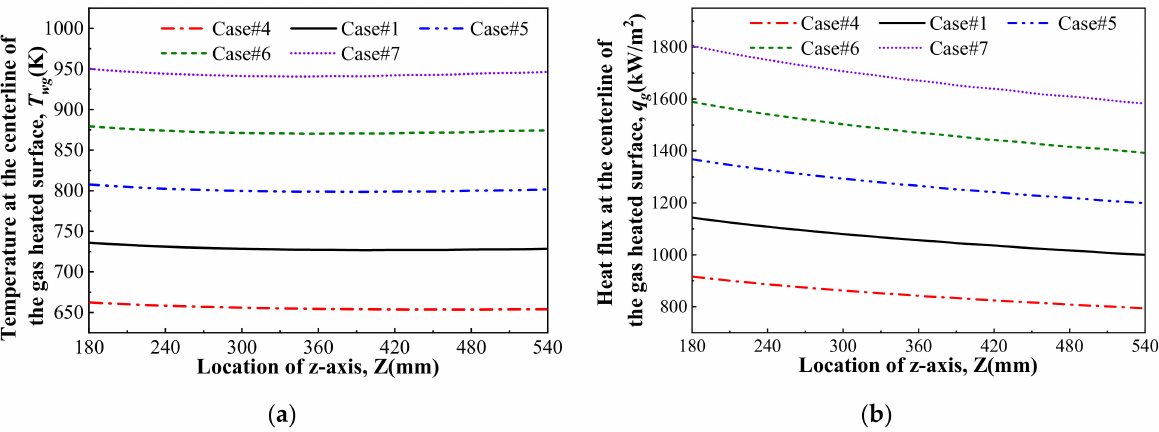
Figure 17. Variation of T wg and q g at the centerline of the gas heated surface with total temperatures of gas: ( a ) T wg ( b ) q g .